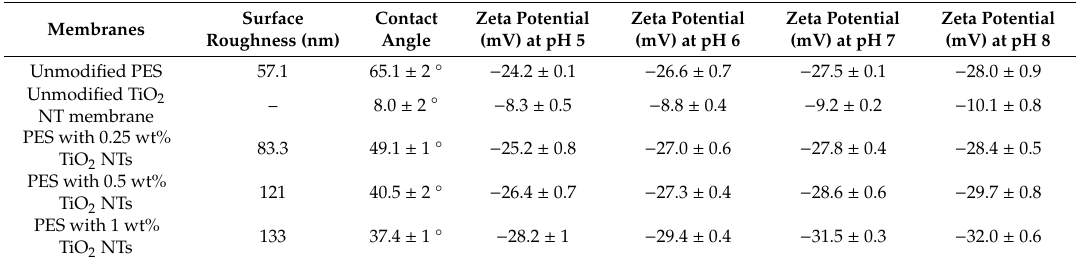
Figure 7. Topography of discrete TiO 2 -based PES membranes using atomic force microscopy: ( a ) 1% TiO 2 / PES membrane; ( b ) 0.5% TiO 2 / PES membrane; ( c ) 0.25% TiO 2 / PES membrane; and ( d ) pristine PES membrane. Table 1. Surface charge / roughness of PES membranes and contact angle measurement